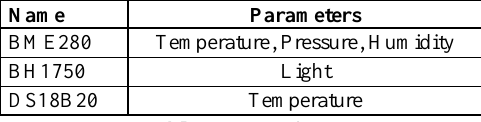
Table 1 . Sensors’